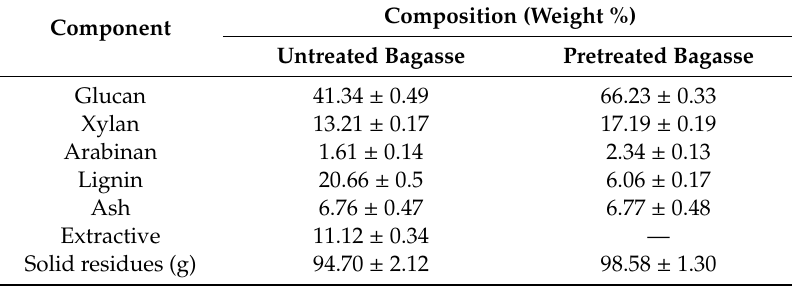
Table 1. Composition of sugarcane bagasse and pretreated bagasse. On a dry basis, the